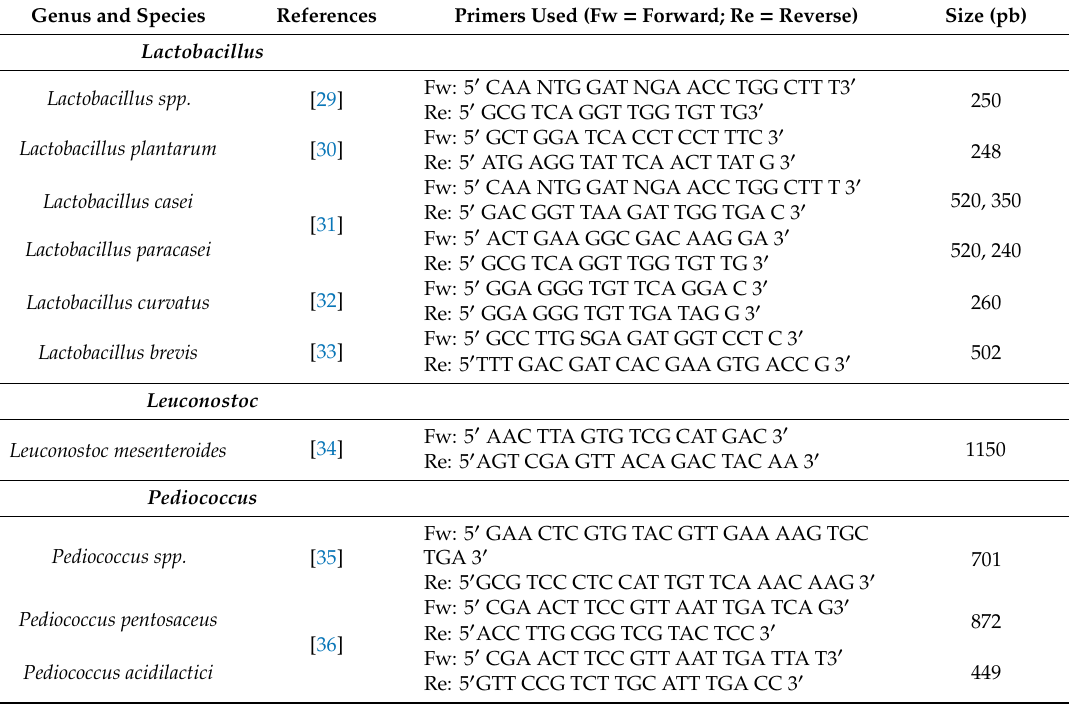
Table 1. Primer details of PCR-based identification of LAB at genus and species level. Genus and